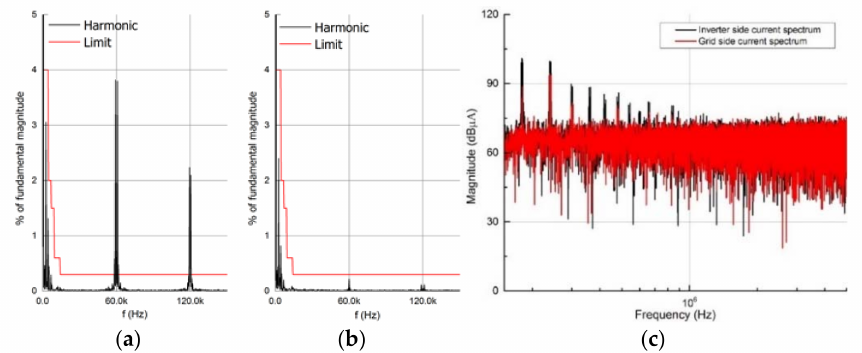
Figure 13. Harmonic distortion of the measured current with the copper foil winding: ( a ) inverter side; ( b ) grid side; and ( c ) reduced current spectrum in grid